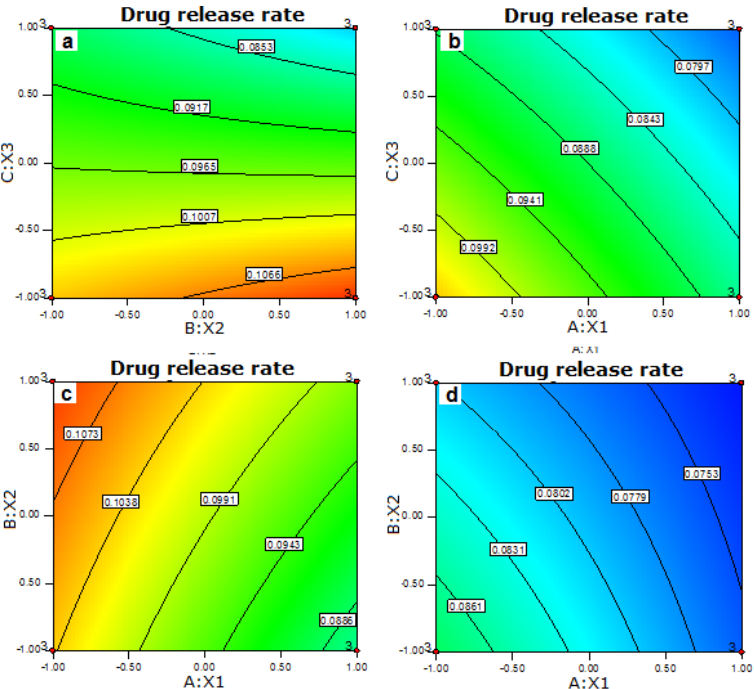
Figure 5. Contour plot of drug release rate a) X 1 at low level, b) X 2 at low level, c) X 3 at low level and d) X 3 at high